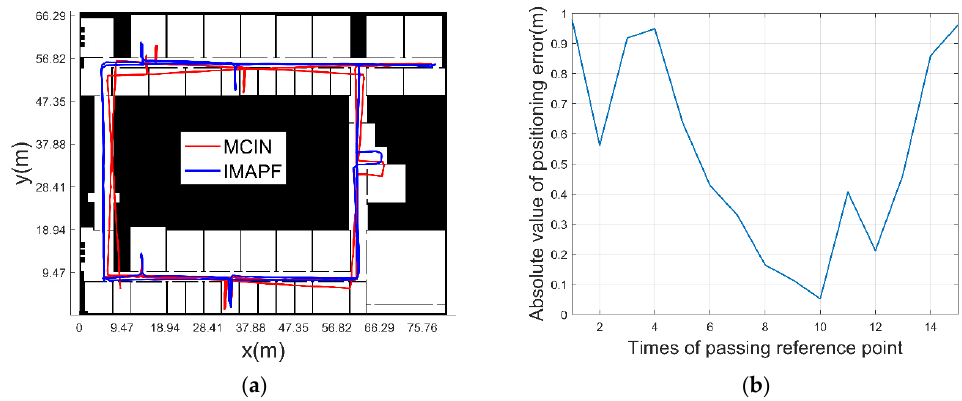
Figure 16. Navigation trace comparison and curve of absolute value of positioning error with known initial position and heading. ( a ) Positioning trace comparison diagram. ( b ) Absolute value of positioning error.